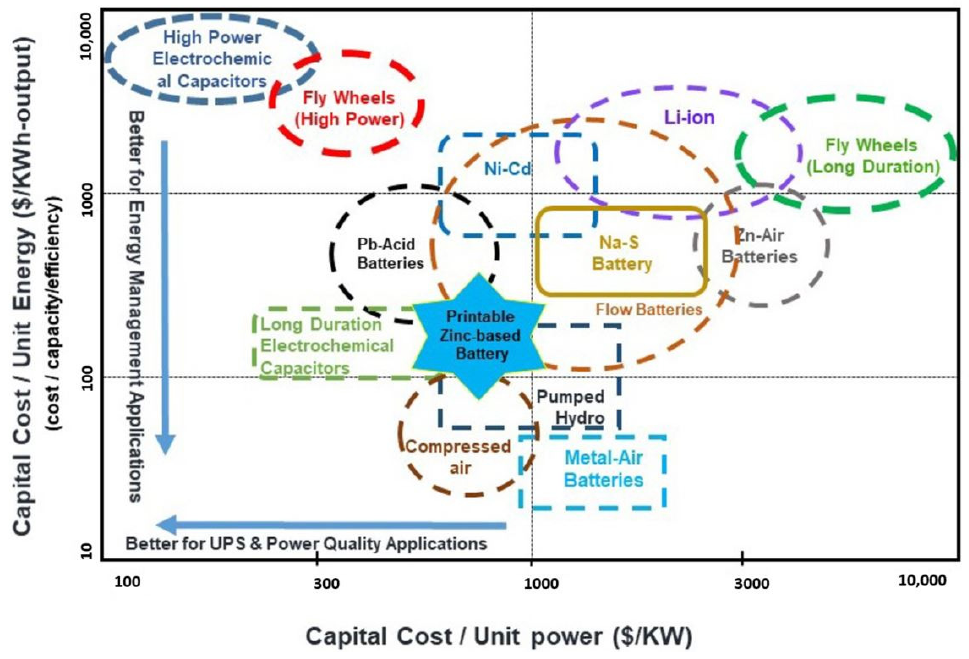
Figure 6. Comparison between roll-to-roll printable zinc-based battery with different energy storage technologies in both capital cost per unit power and unit energy.